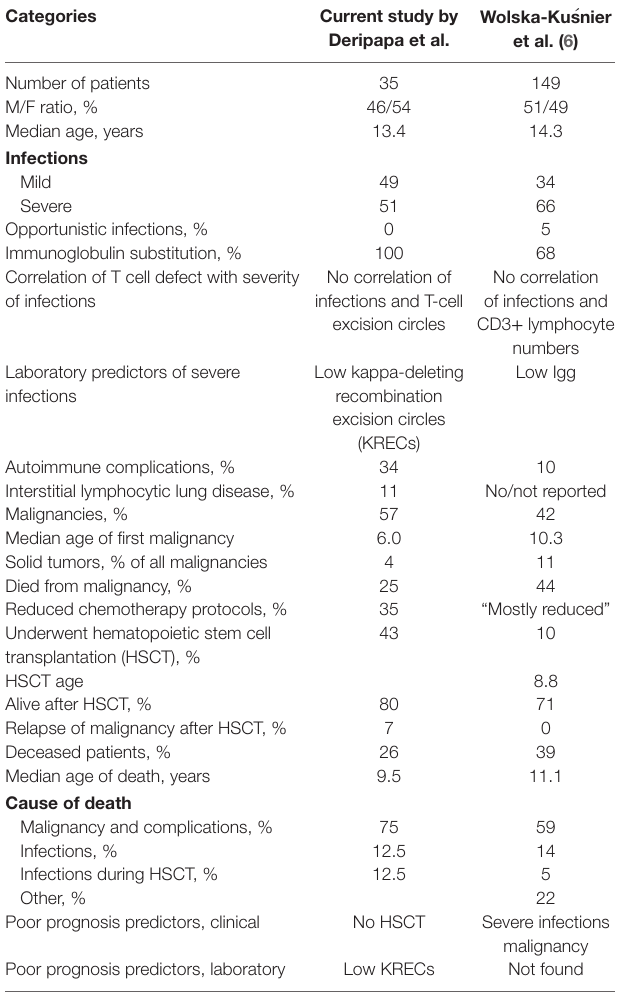
TaBle 2 | Comparison of clinical and laboratory findings in two studies of Nijmegen Breakage Syndrome patients: current (Deripapa et al.) and Wolska- Kus ˊ nierz et al.